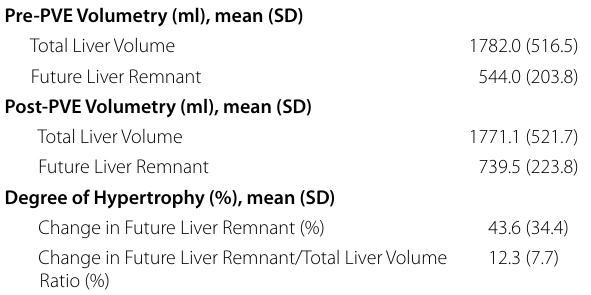
Table 2 Volumetric outcomes Pre-PVE Volumetry (ml), mean